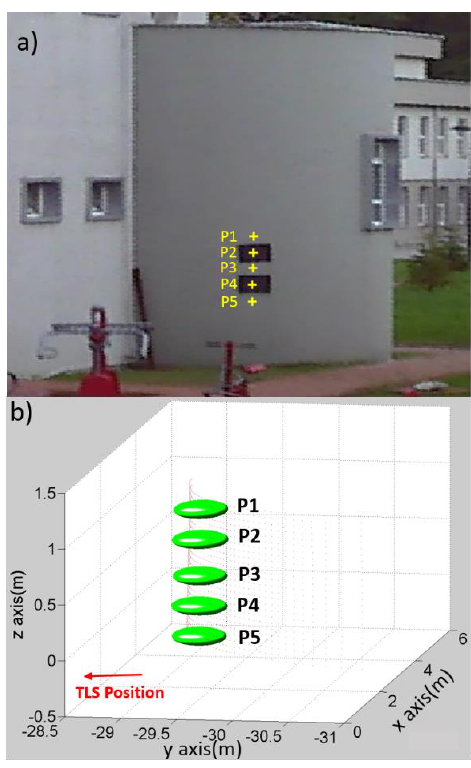
Figure 10. Test object and selected points for error ellipsoid plotting (a). Error ellipsoids corresponding to P1-P5 (b). At the last scenario, test objects were lamp poles and a branch of a tree. These objects were intentionally chosen, because the reflectance of lamp poles are very low compared to the tree branch. Three points were selected, P1 and P3 from the lamp poles and P2 was from the branch of a tree. P2 had the smallest incidence angle (≈14°), P1 had the biggest incidence angle (≈40°) and incidence angle of P3 was almost equal to 30°. Test objects and selected points are shown in Figure